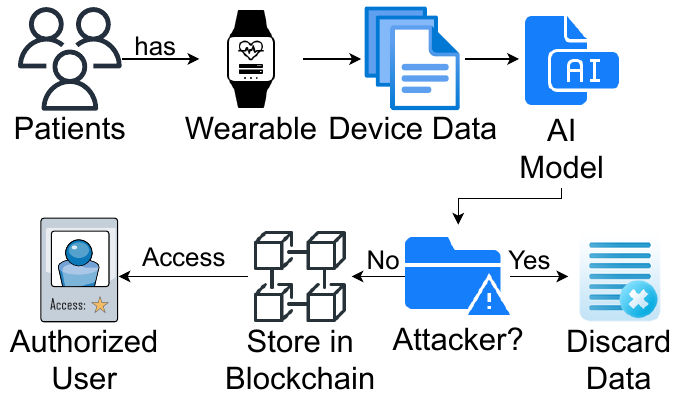
Figure 1. System